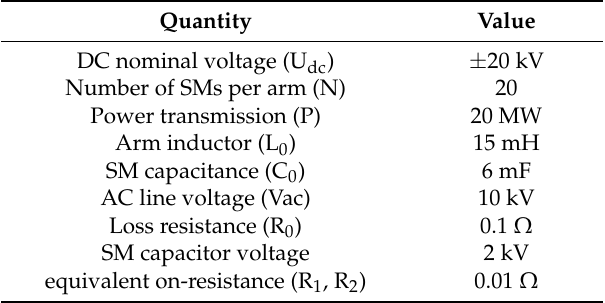
Table A1. Parameters of the simulated MMC